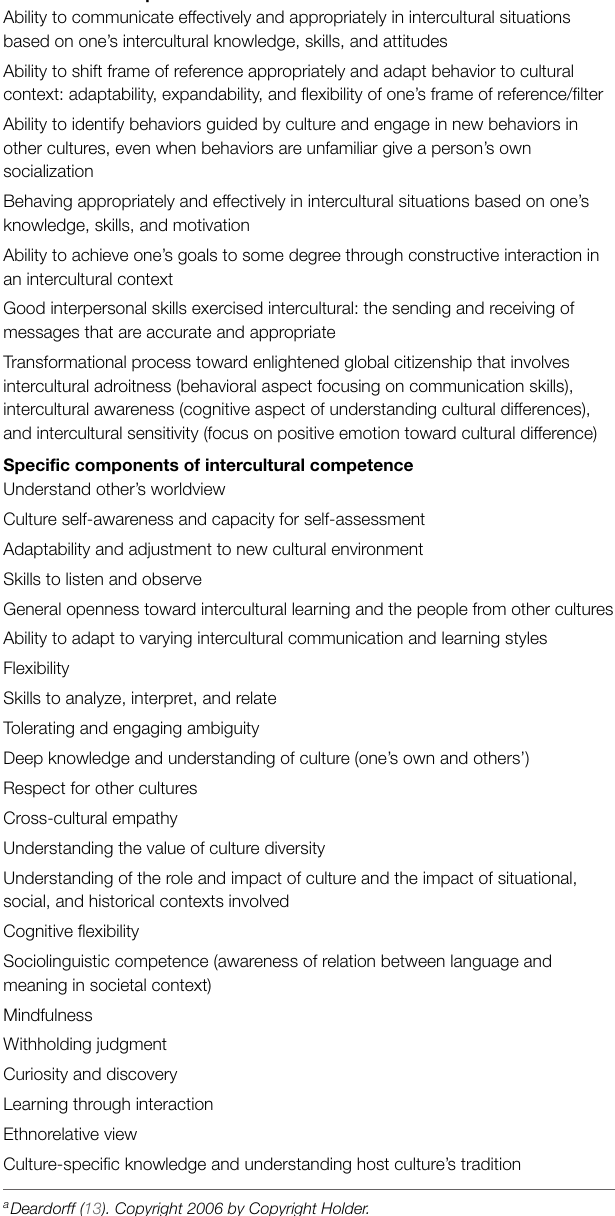
TABLE 1 | Intercultural competence elements with 80–100% agreement among top intercultural scholars a . Intercultural competence Ability to communicate effectively and appropriately in intercultural situations based on one’s intercultural knowledge, skills, and attitudes Ability to shift frame of reference appropriately and adapt behavior to cultural context: adaptability, expandability, and flexibility of one’s frame of reference/filter Ability to identify behaviors guided by culture and engage in new behaviors in other cultures, even when behaviors are unfamiliar give a person’s own